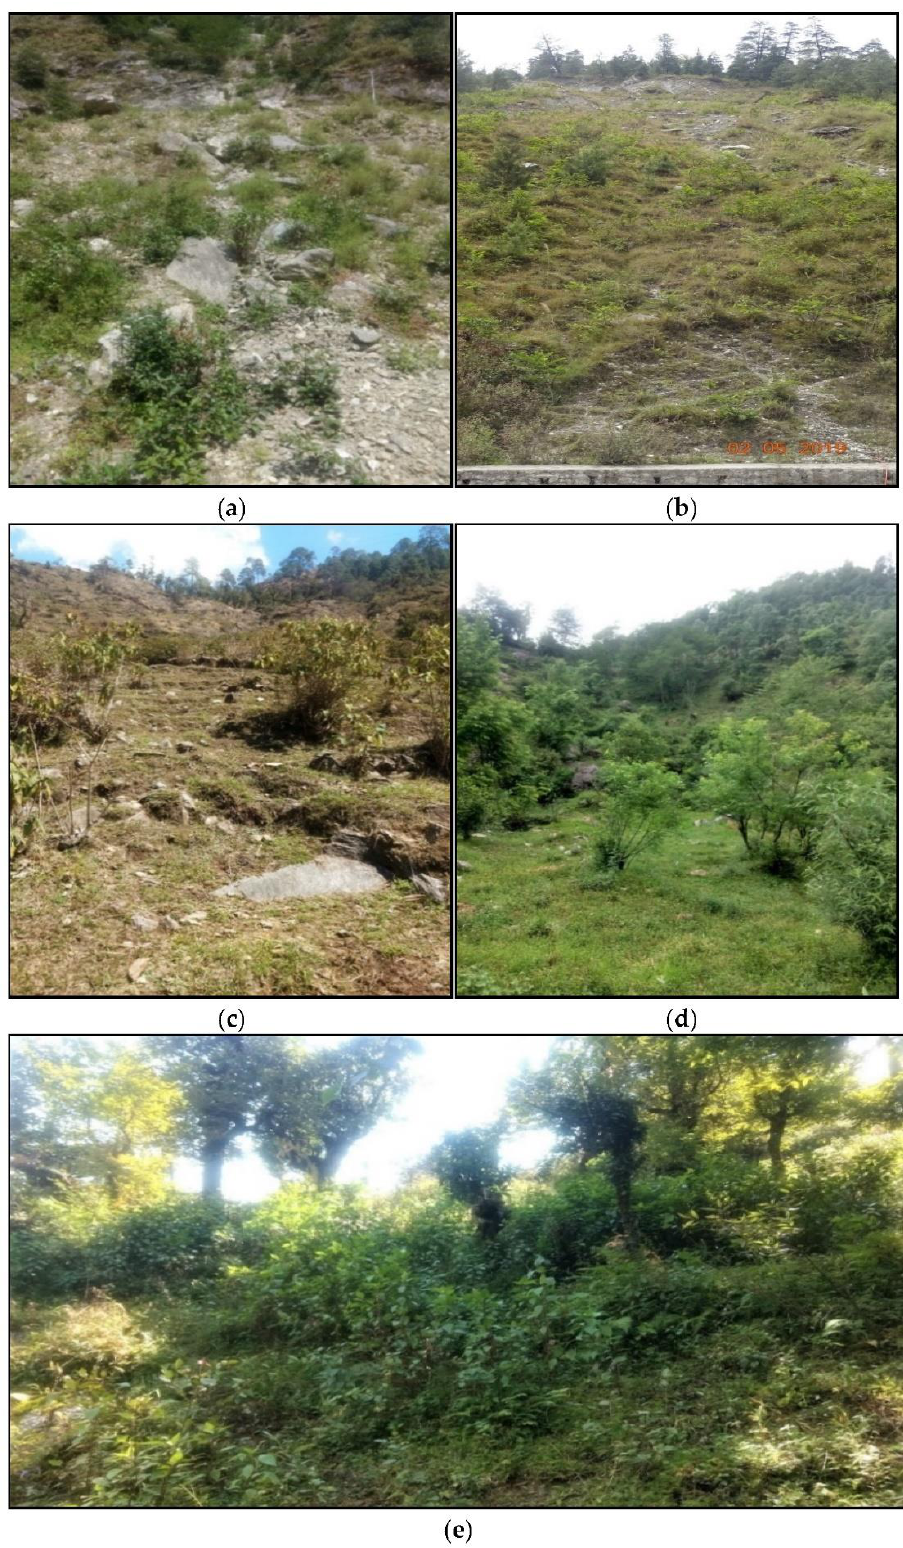
Figure 3. Photos of the study sites. ( a ) L 6 , landslide site of 2013, ( b ) L 16 , landslide site of 2003, ( c ) L 21 , landslide site of 1998, ( d ) L 26 , landslide site of 1993, ( e ) reference (control) site.